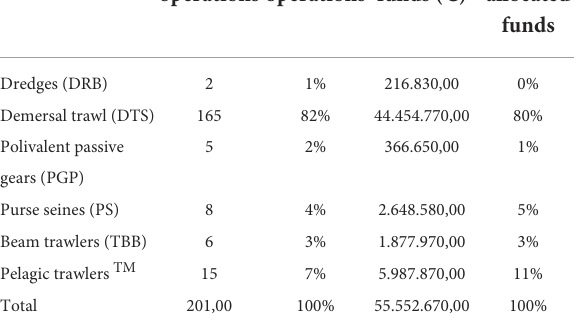
Deeper analysis on the impact of EMFF measures under Art. 34 and Art.